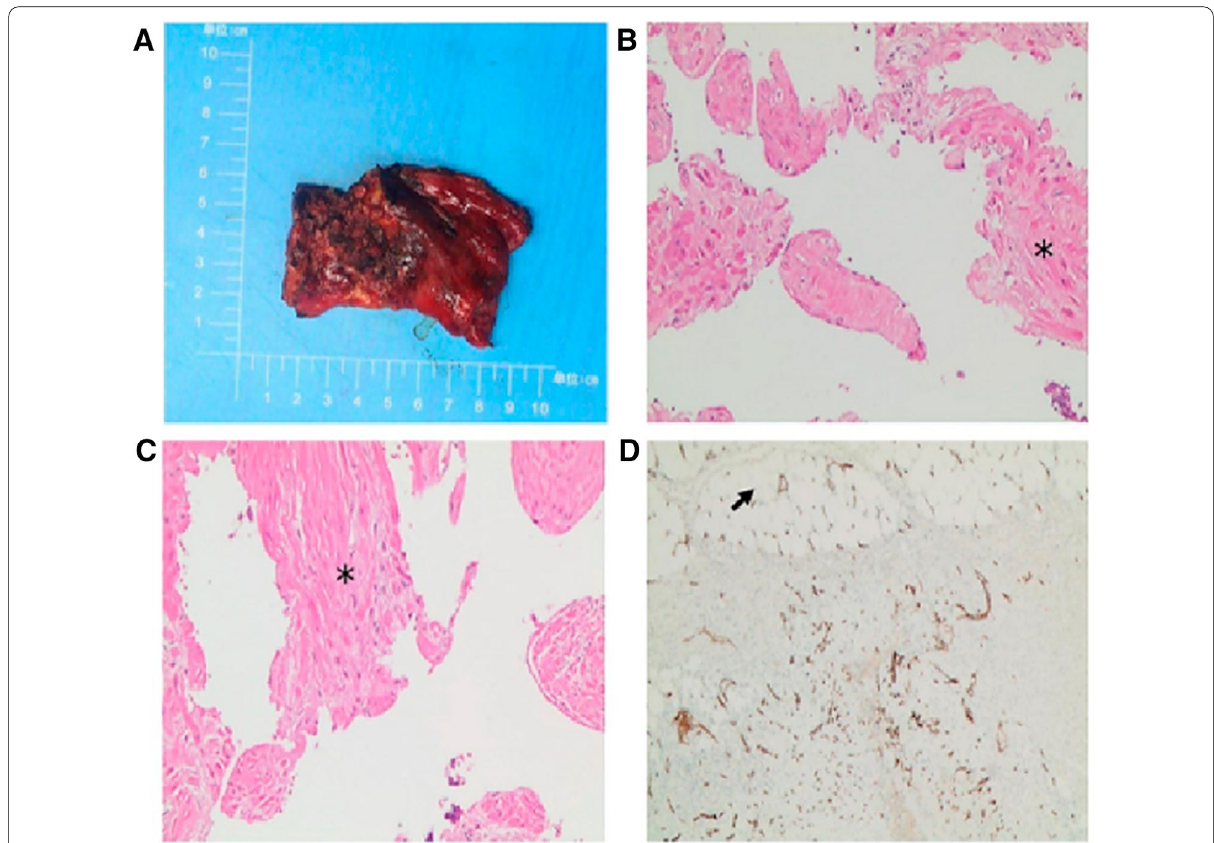
Fig. 2 A Gross image of the tumor and right psoas major muscle which is difficult to be isolated after excision showing the size of 90 mm 50 mm 12 mm. B Section in tumor mass showing hemangioma like changes (asterisk key) (H&E, 20 × × thick-walled vessels with thrombosis and bleeding (H&E, 20 20). D Section in tumor showing mature adipocytes (black arrow), and perivascular × epithelioid cells were not found (immunohistochemistry for